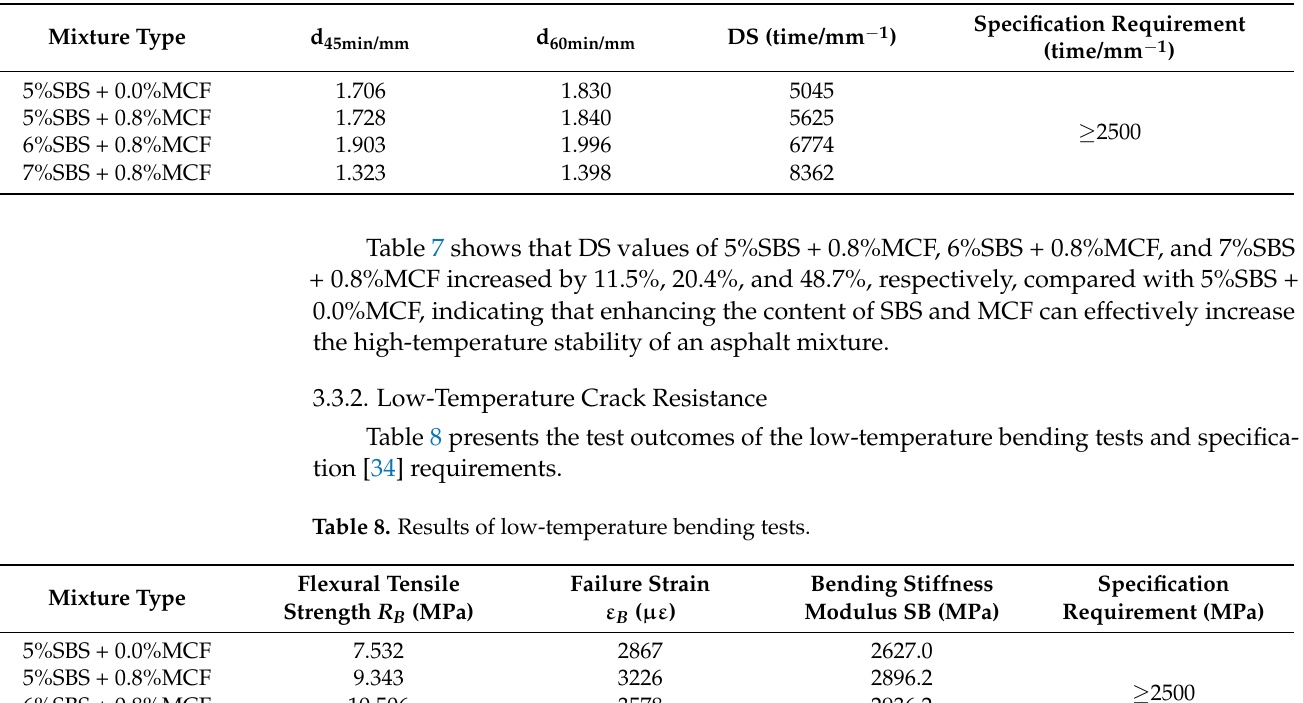
Table 7. Results of the rutting test.